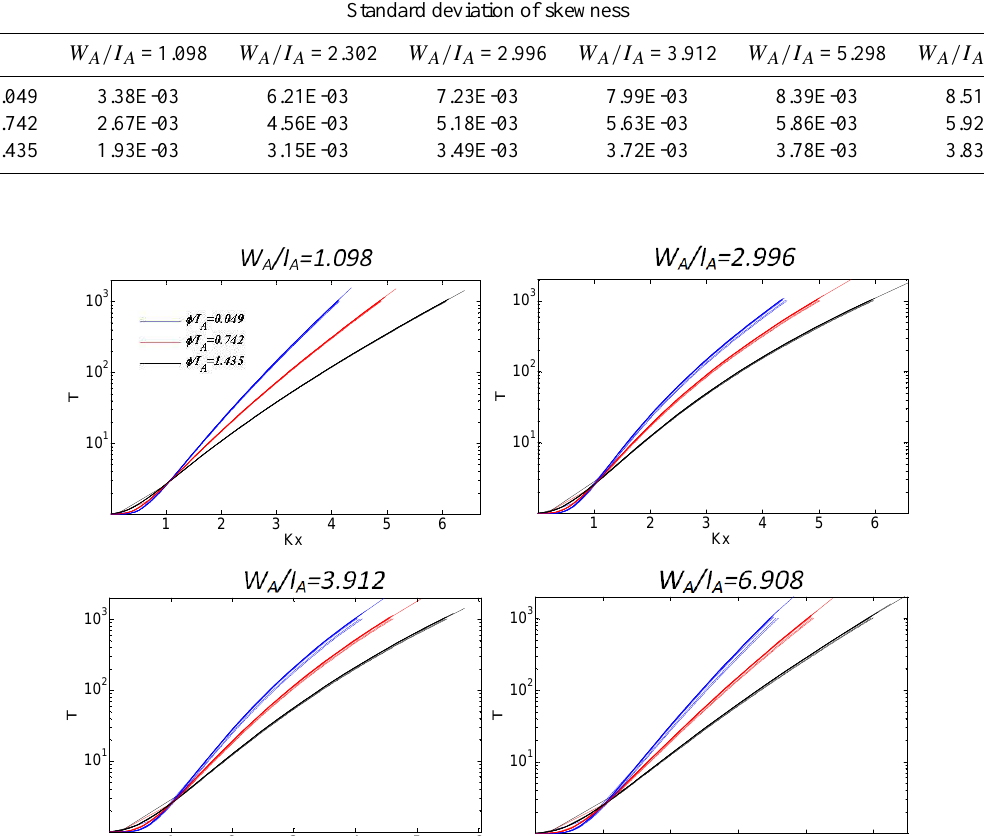
Fig. 1. Growth curves obtained for r L =0.1, r H =0.3, and different values of φ/I A (as in the legend), I 1 (10, 50mmh − 1 ), A (10, 50, 100, 200, 500km 2 ), W A /I A (in